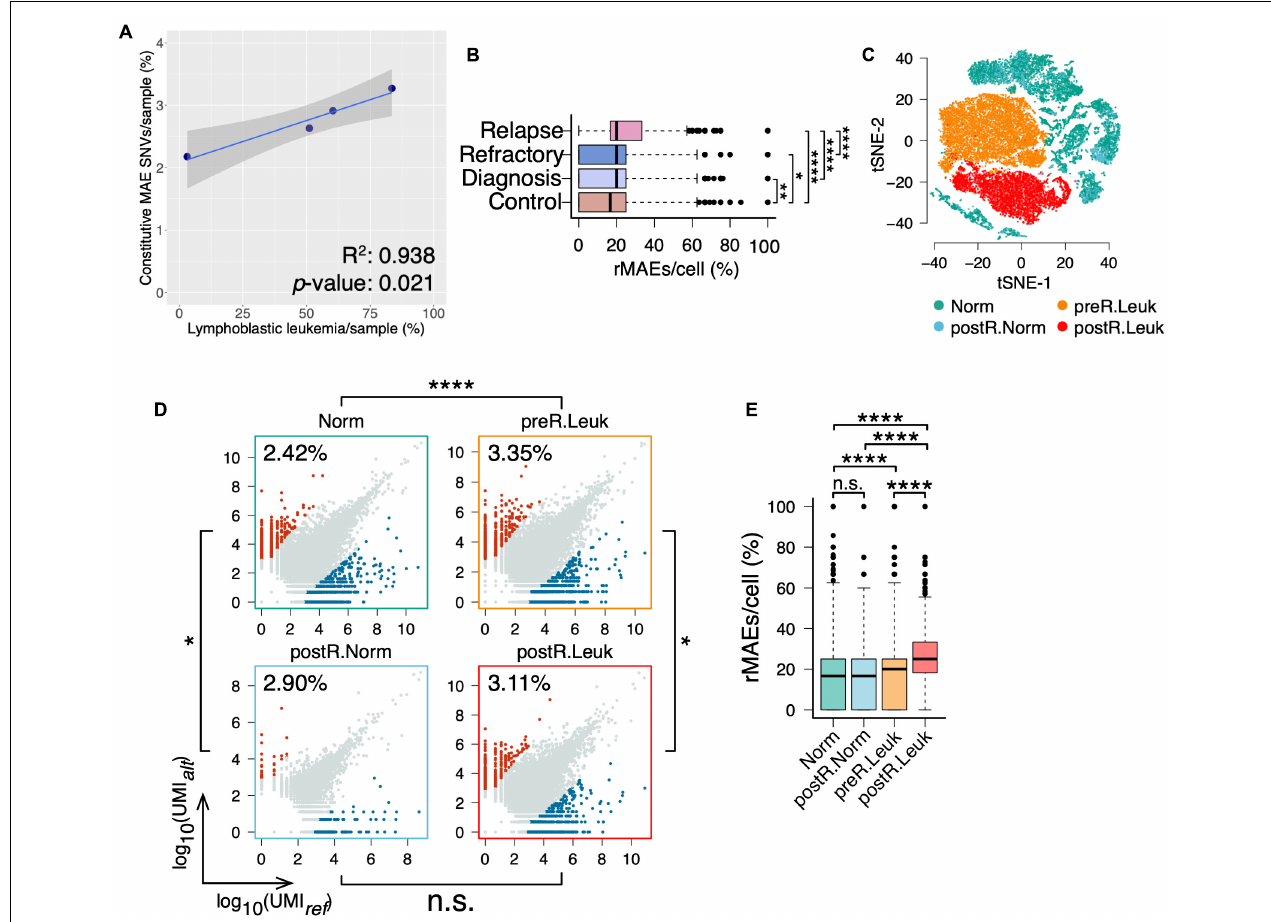
FIGURE 4 | Leukemia cells showing increased constitutive MAEs and rMAEs. (A) The fractions of constitutive MAEs are correlated with the fractions of leukemia cells in BMMCs. (B) The fractions of rMAE per cell in BMMCs from control, diagnosis, refractory, and relapse. (C) tSNE projection of all BMMCs from the boy diagnosis with leukemia, colored by the inferred cell states, namely, leukemia cells before relapse (preR.Leuk), non-leukemia cells before relapse (Norm), leukemia cells after relapse (postR.Leuk), and non-leukemia cells after relapse (postR.Norm). (D) Constitutive MAEs of Norm cells, preR.Leuk cells, postR.Norm cells, and postR.Leuk cells. (E) The fractions of rMAE per cell of Norm cells, preR.Leuk cells, postR.Norm cells, and postR.Leuk cells.* p < 0.05, ** p < 0.01, *** p < 0.005, and **** p <